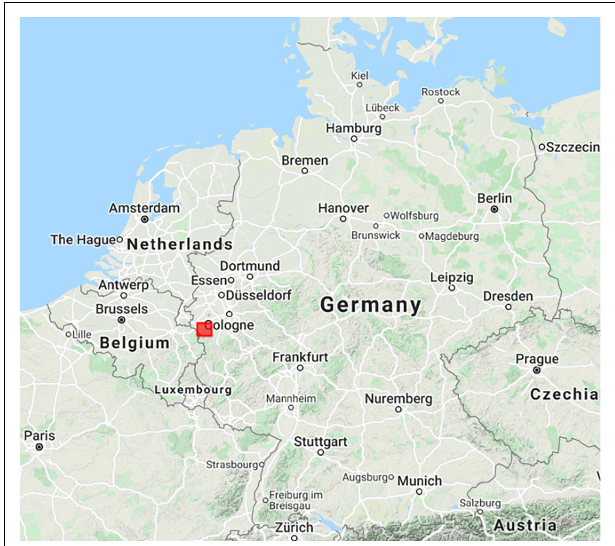
FIGURE 1 | Location of the area under investigation in the Northern Eifel as provided by the